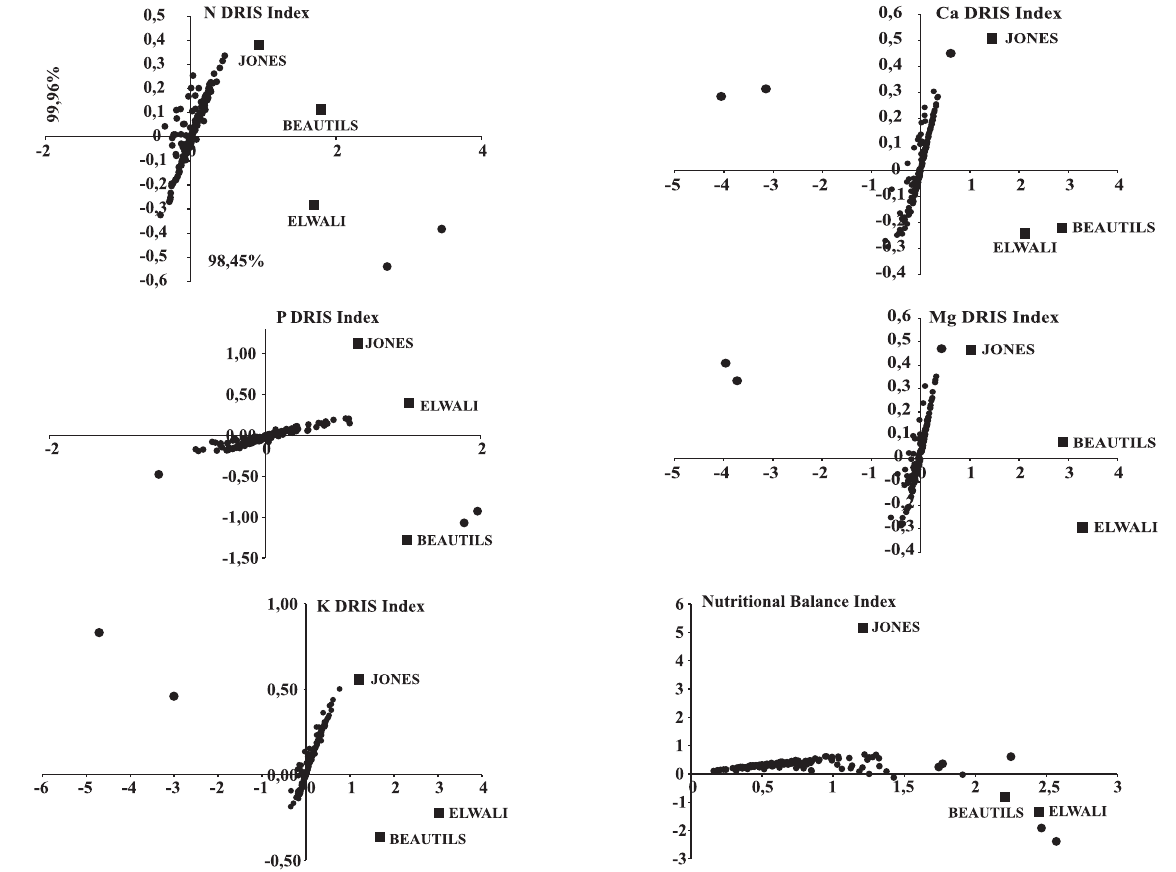
Figure 1. Spatial distribution of N, P, K, Ca and Mg DRIS indices and NBI based on the evaluation of the nutritional status of 153 cupuaçu orchards by different DRIS functions (Beaufils, 1973; Jones, 1981; Elwali & Gascho (1984), 1984).